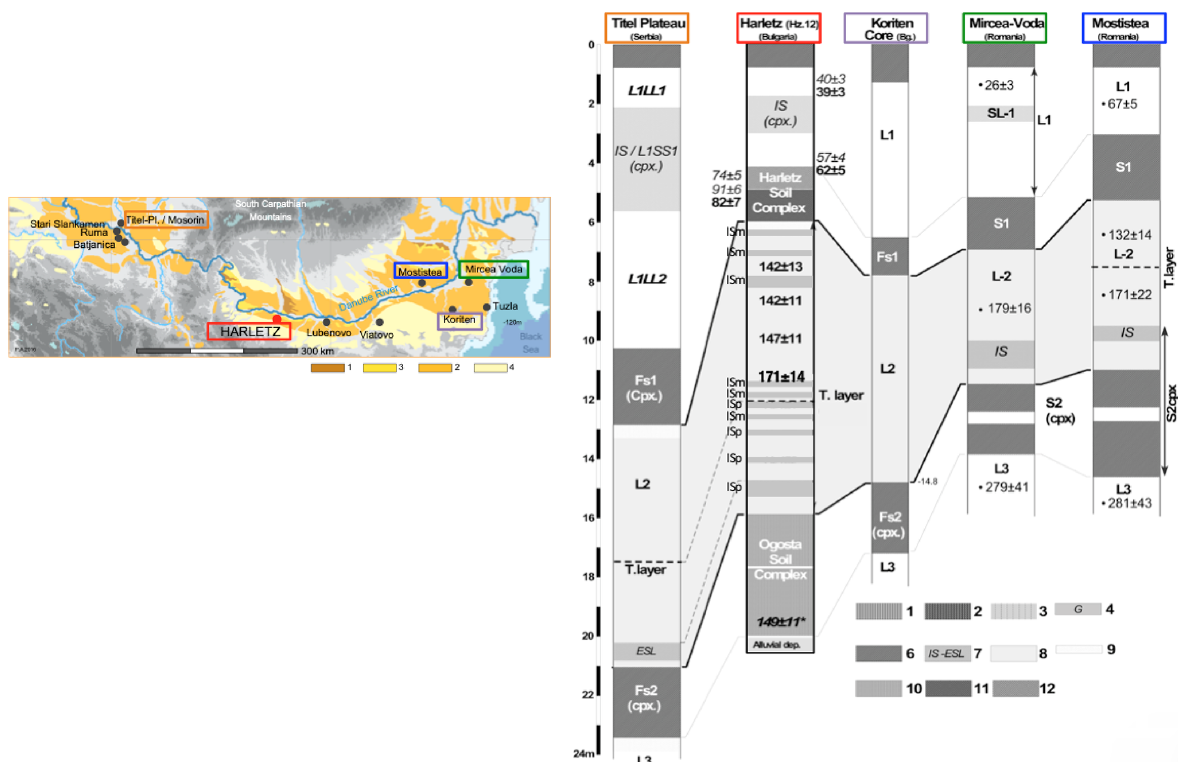
Figure 2. Correlation between the last two climate cycles from the southern Europe loess sequences along the Danube, modified after Antoine et al. (2019). Map of the locations (see Fig. 1b); the colored rectangles on the map (left) refer to the pedostratigraphic sequences correlated on the correlation sketch (right). Interstadials ISp and ISm (this study; see Fig. 1c) are reported on the Harletz